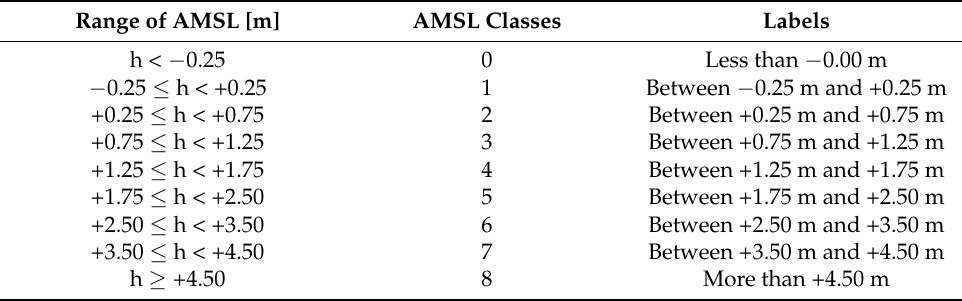
Table 1. Range of values to reclassify DTM raster dataset. Range of AMSL